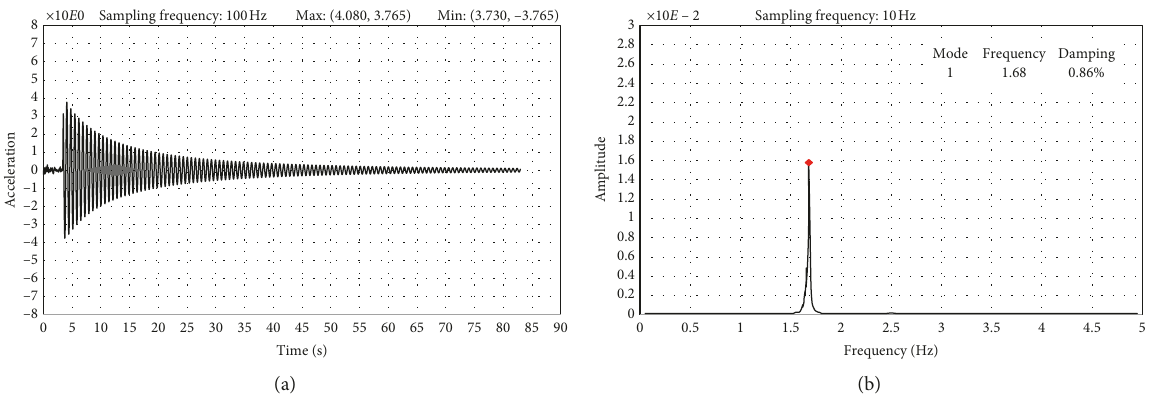
Figure 18: Monitoring results with the particle damper (9 steel balls in container). (a) Acceleration-time history curve of the frame. (b) Identified frequency and damping ratio.